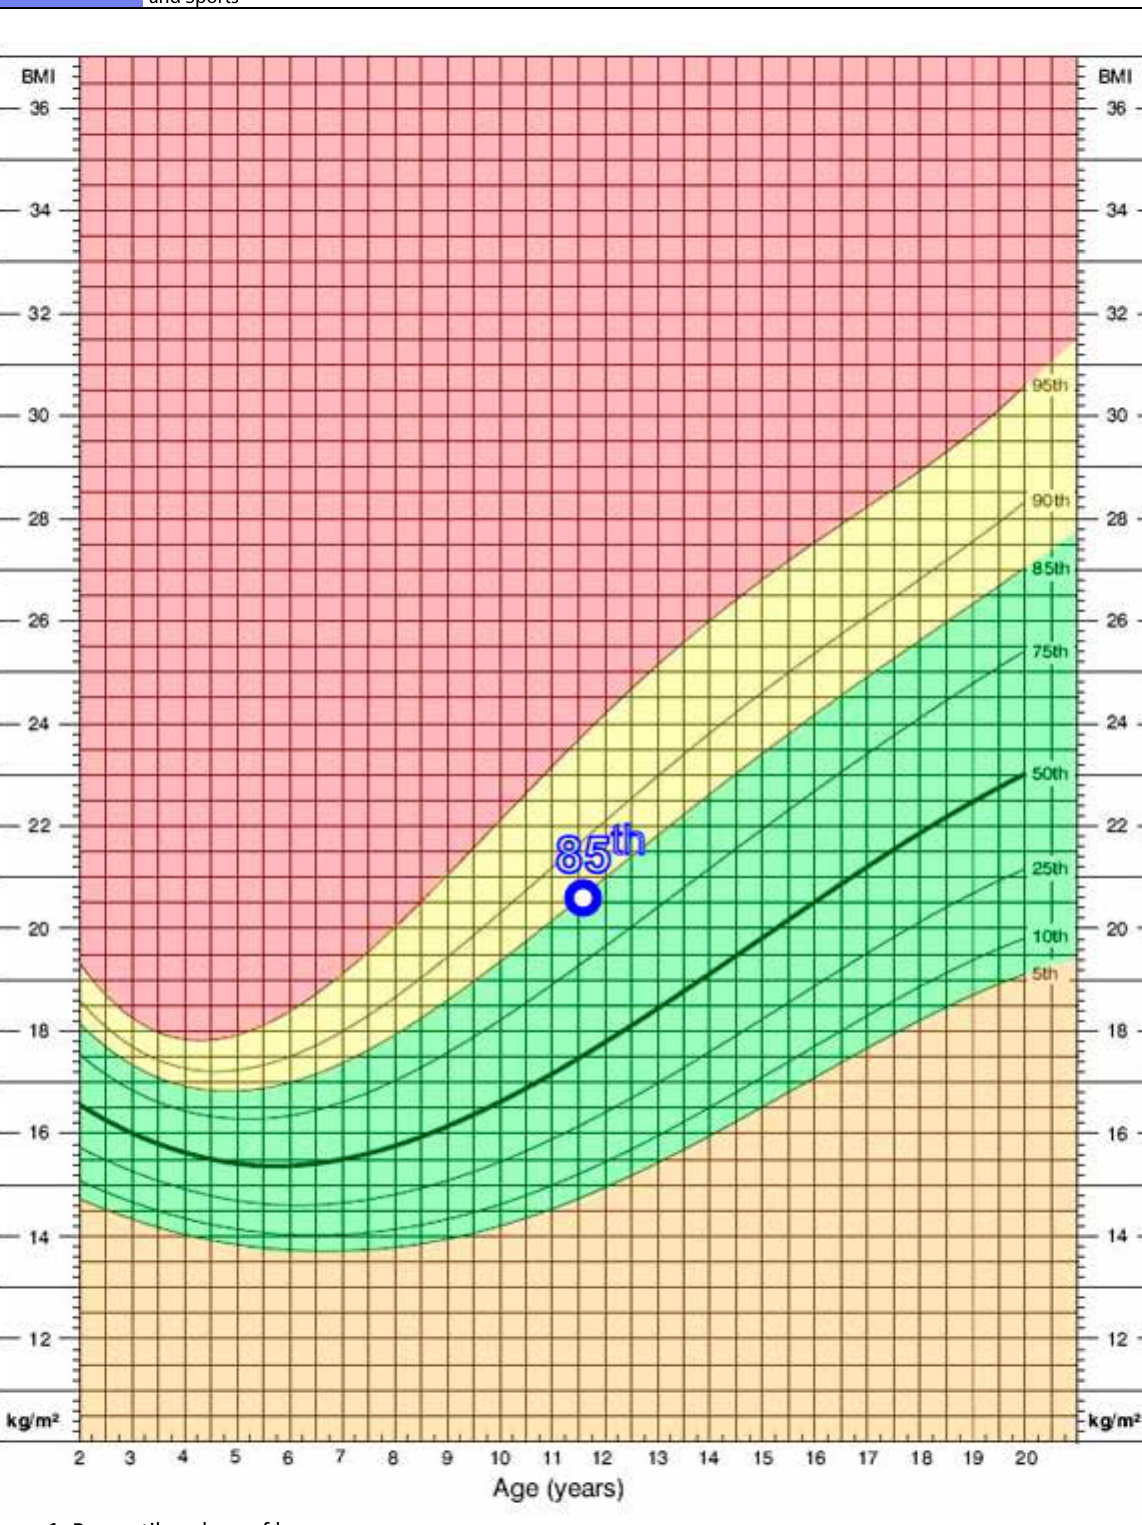
epidemiological proportions, where otherwise 1.3